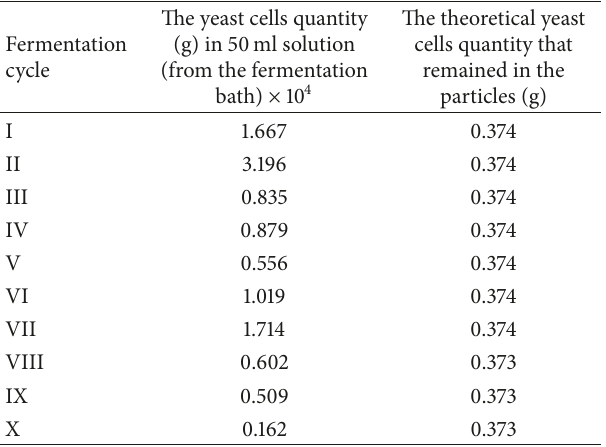
Table 6: Theoretical concentration of yeast cells in the PD5 particles after each fermentation cycle.